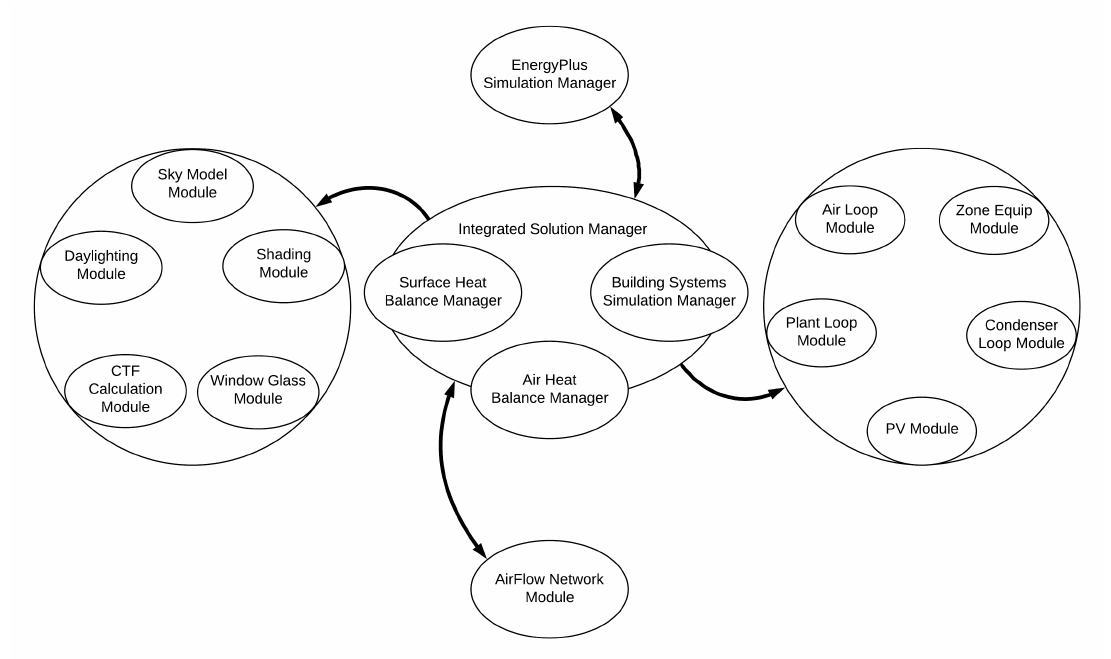
Figure 3. Example of schematic description of commonly used software for dynamic simulation of building energy